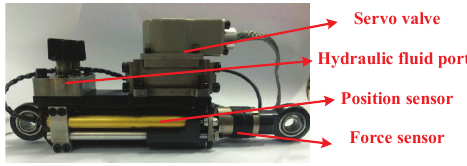
Figure 4. The structure of the hydraulic